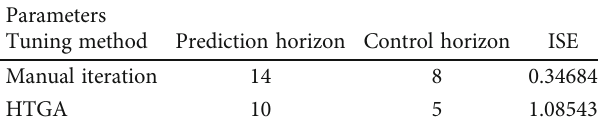
Table 2: Optimal parameters of MPC and performance